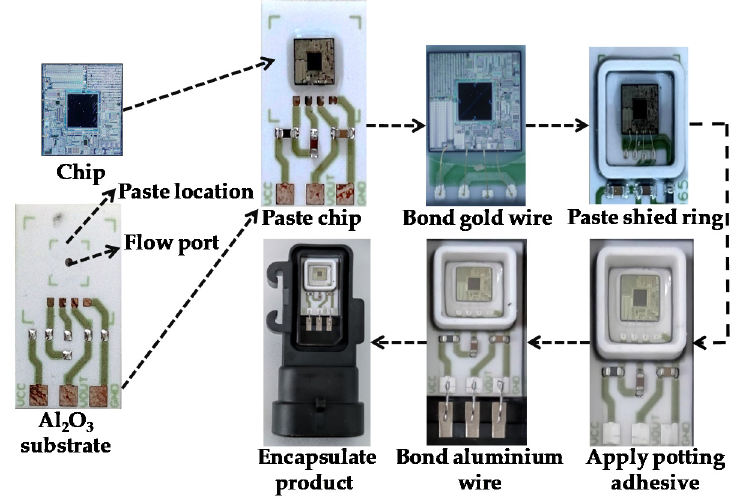
Figure 2. Packaging process of the MEMS pressure sensor.